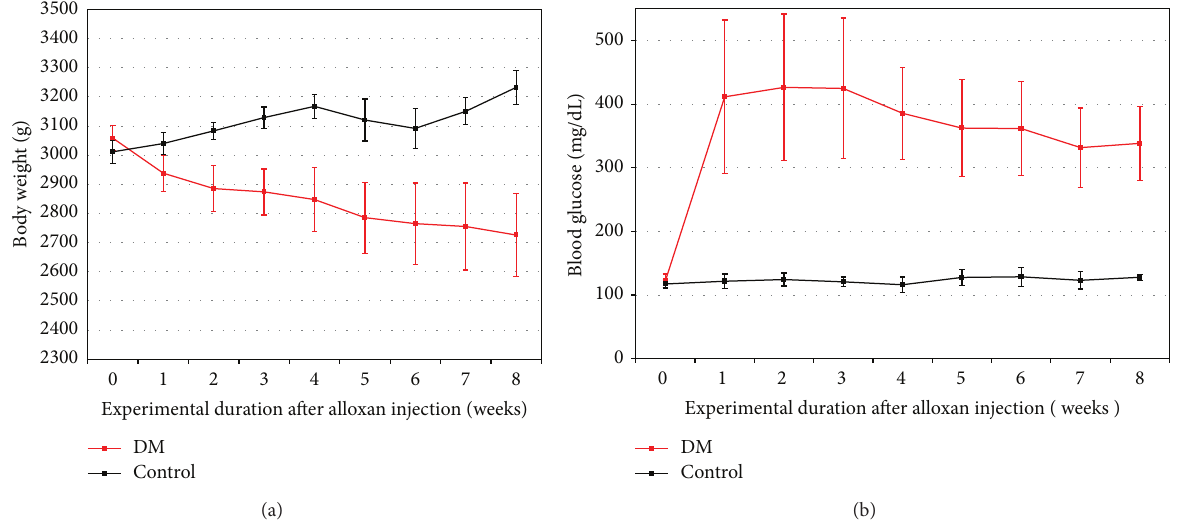
Figure 5: (a) Average body weights of alloxan-induced diabetic rabbit throughout the 8-week experimental period. (b) Blood glucose levels of alloxan-induced diabetic rabbit throughout the 8-week experimental